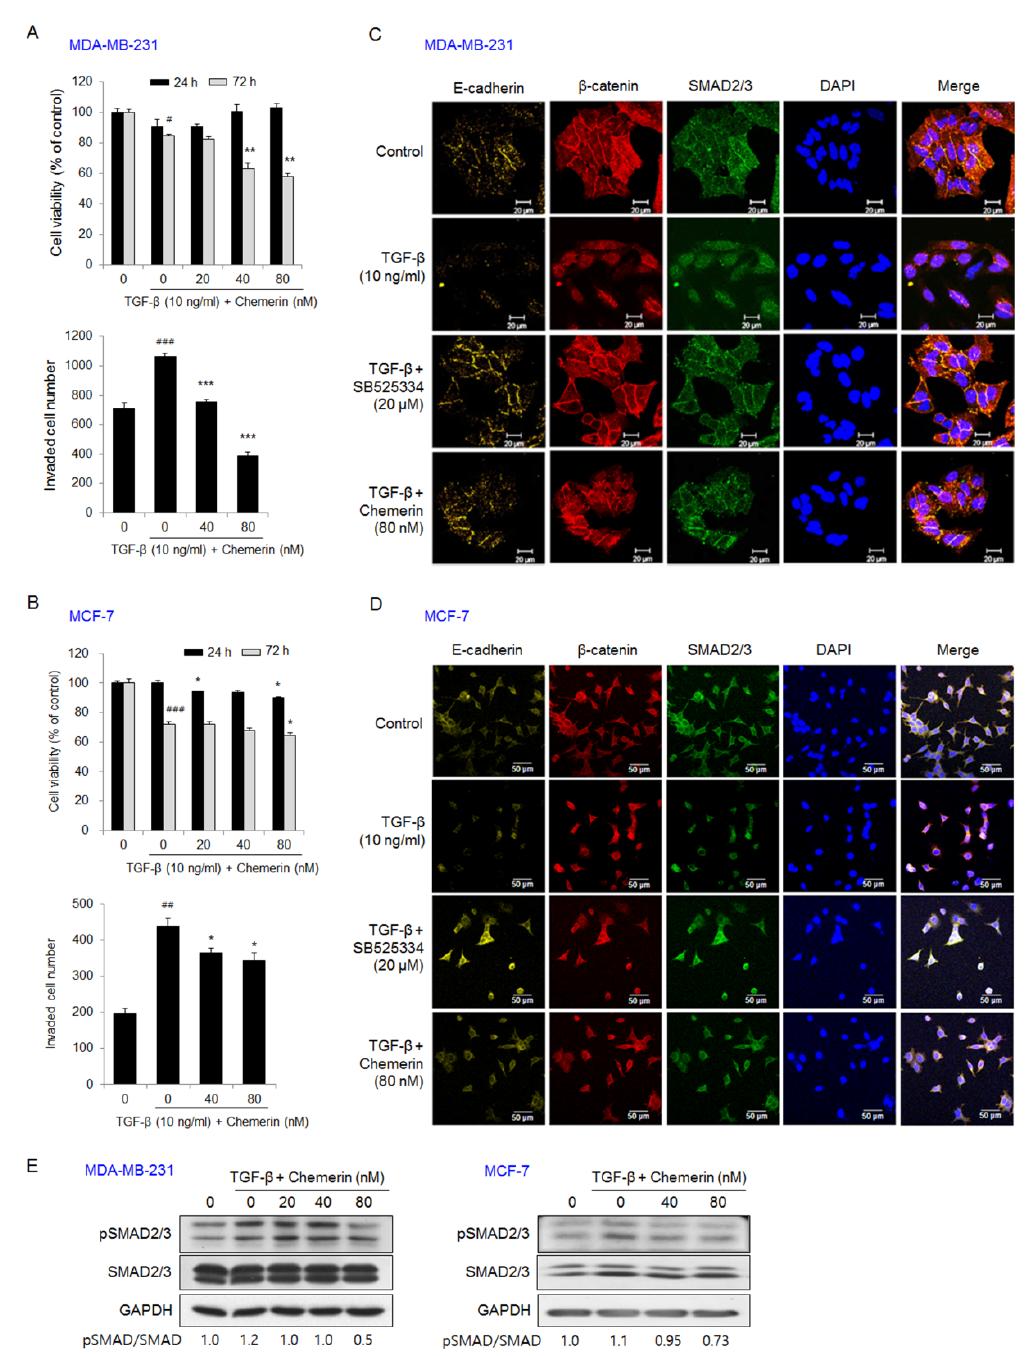
Figure 2. Chemerin suppressed the viability, invasion, and EMT of transforming growth factor (TGF)- β -treated breast cancer cells. ( A , B ) The viability and invasion of (A) MDA-MB-231 or (B) MCF-7 cells treated with chemerin in the presence of TGF- β . Cell viability was measured by an MTT assay after 24 h and 72 h of treatment with TGF- β and chemerin. Cell invasion was measured using a Transwell chamber and determined by counting the number of invaded MDA-MB-231 and MCF-7 cells 24 h after TGF- β and chemerin treatment. ( C , D ) The expression levels and cellular localization of E-cadherin, β -catenin, and smad2 / 3 in ( C ) MDA-MB-231 and ( D ) MCF-7 cells treated with chemerin or SB525334 (TGF- β type I receptor inhibitor) in the presence of TGF- β for 24 h. The cells were immunostained with specific primary antibodies against β -catenin, E-cadherin, or SMAD2/3 and then with Alexa Fluor 488 goat anti-mouse IgG or Alexa Fluor 594 goat anti-rabbit IgG. The slides were mounted with Vectashield mounting medium with 4 ′ ,6-diamidino-2-phenylindole (DAPI). The images were collected using a Zeiss LSM 700 confocal microscope. Representative immunofluorescence images. Scale bar, 20 μ m in MDA-MB-231 cells and 50 μ m in MCF-7 cells; ( E )